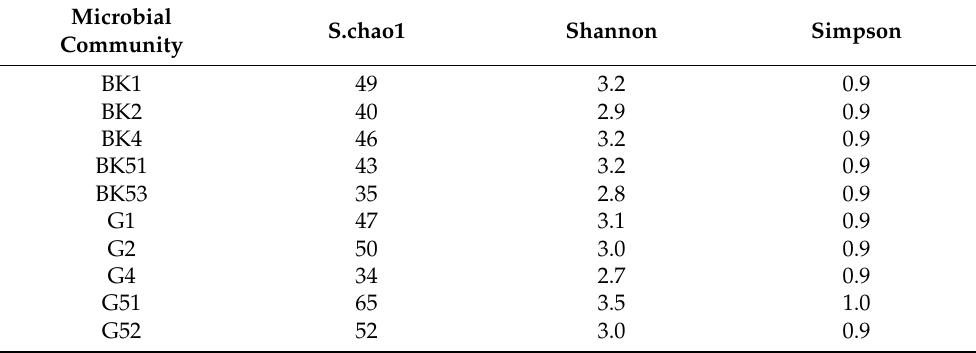
Table 4. Alpha-diversity of pufM -containing microbial communities of epilithon (G51, G52, BK51, BK53), neuston (BK1, G1), and plankton (BK2, BK4, G2, G4) of Lake Baikal. BK—samples taken off the Bol’shiye Koty settlement; G—samples taken off the Bol’shoye Goloustnoye settlement. Microbial S.chao1 Community